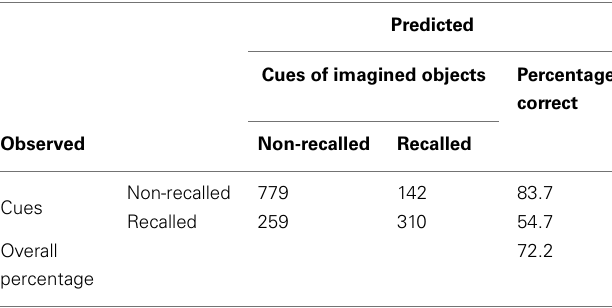
TableA3 | Evaluation result for logistic regression predictive model for incidental recall using stimuli and vividness as